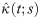
Intraday cross-sectional kurtosis v semester s.The symbols (and the bars) represent κ^(t;s) averaged over intraday time with t > 60.